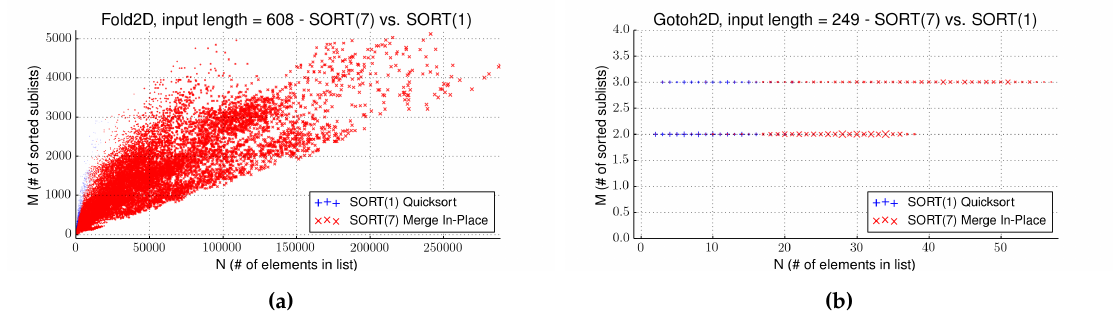
Figure 4. Runtime gain of individual data points of Algorithm 7 against Algorithm 1 for the test cases ( a ) Fold2D and ( b ) Gotoh2D. Points are plotted when one algorithm performed better than the other with point sizes relative to the gained time. Gotoh2D shows only very little variance in list sizes contrary to Fold2D, explaining the performance